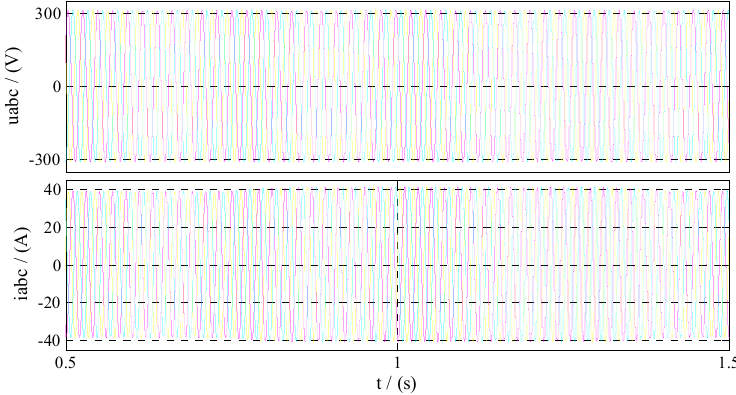
Figure A2. System output voltage and current when the frequency increases by 0.3 Hz.